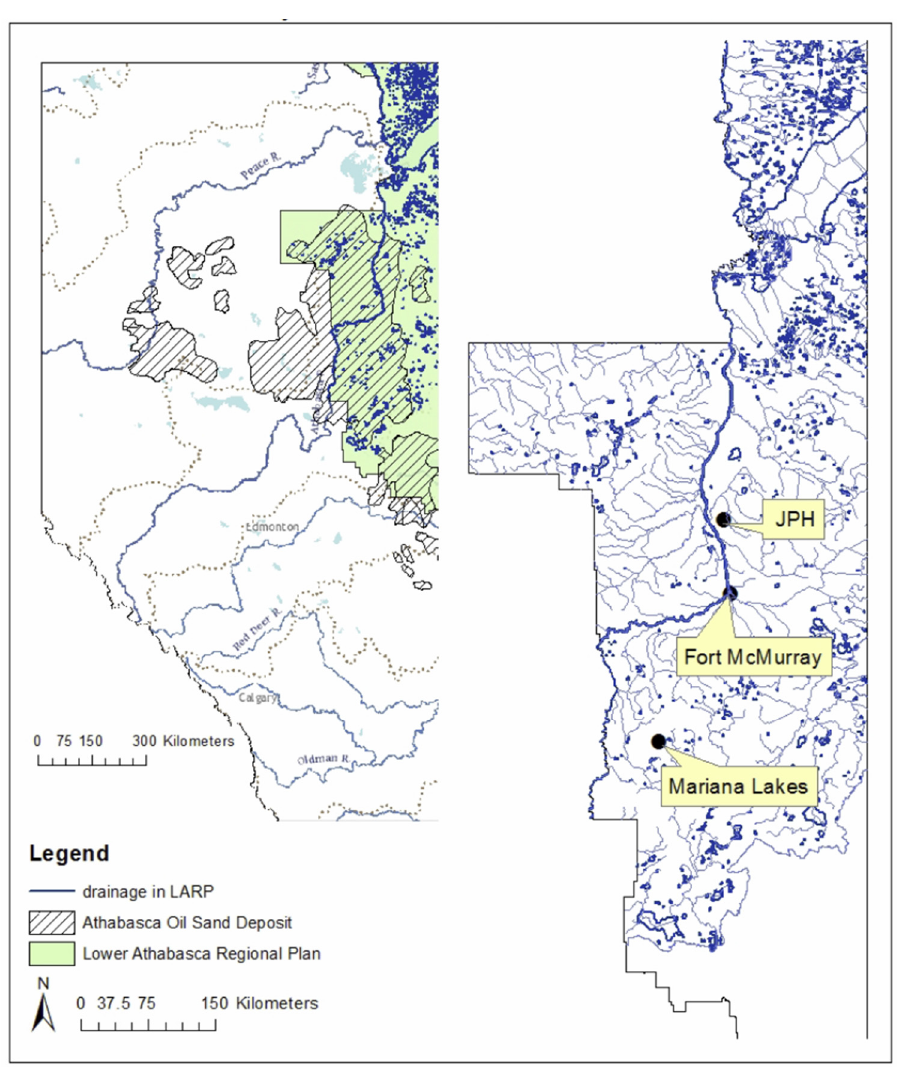
Figure 1. Map of Alberta, Canada (inset) showing location of JPH and Mariana Lakes study sites.